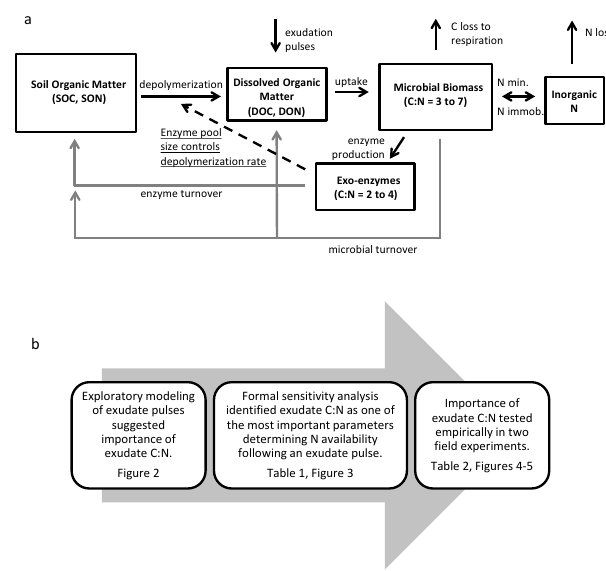
Figure 1. Structure of the decomposition model (a) and graphical description of how the modeling motivated the field experiment (b). In (a), solid arrows refer to fluxes and boxes refer to pools. The turnover of dead microbes and inactivated enzymes into soil organic matter and dissolved organic matter pools are shown as grey arrows, and the importance of enzymes in depolymerizing soil organic matter into dissolved pools is shown with a dotted arrow. “N min.” refers to N mineralization, and “N immob.” refers to the immobilization of inorganic N into microbial biomass. A detailed description of the model equations can be found in Appendix A.